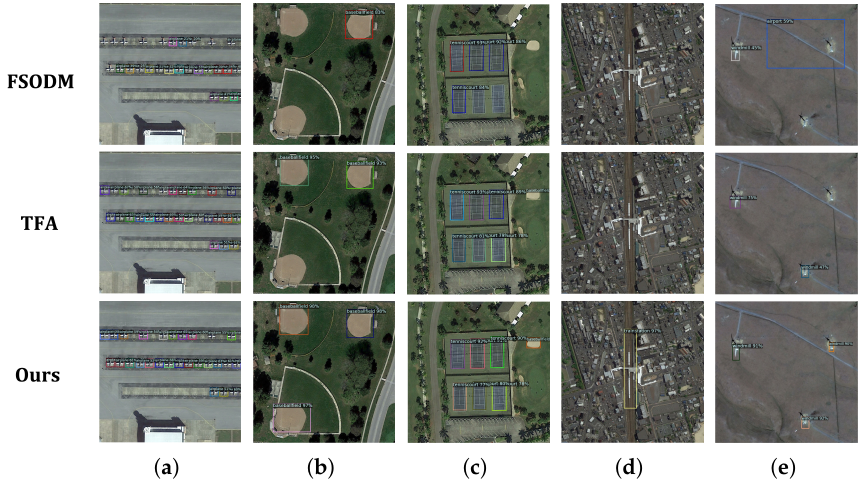
Figure 7. Qualitative inference results of novel categories on the DIOR dataset. ( a ) airplane,